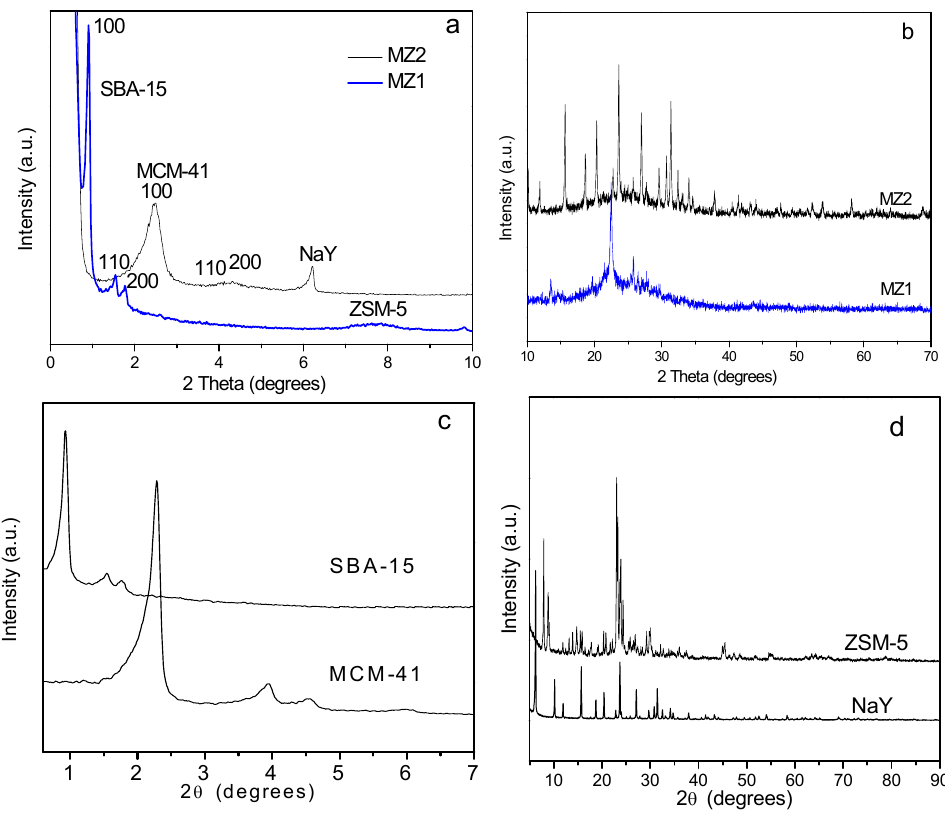
Figure 1. ( a , c ) Low-angle and ( b , d ) wide-angle XRD of the synthesized